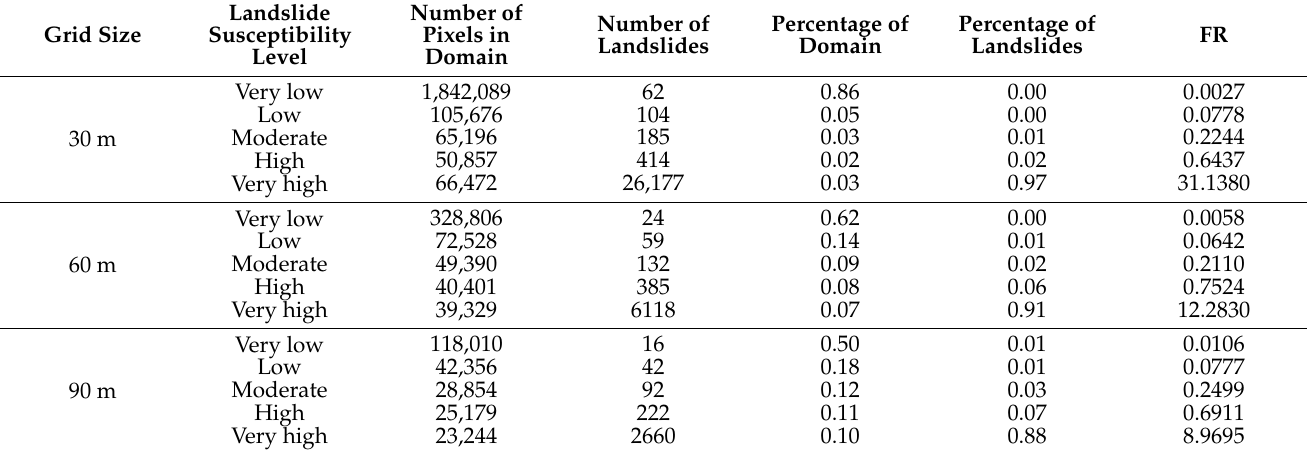
Table 5. gcForest zoning model of landslide